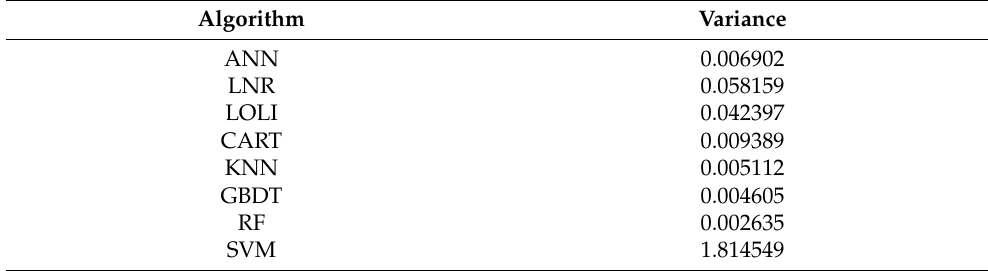
Figure 7. R 2 of eight algorithms. Table 9. Variances of eight